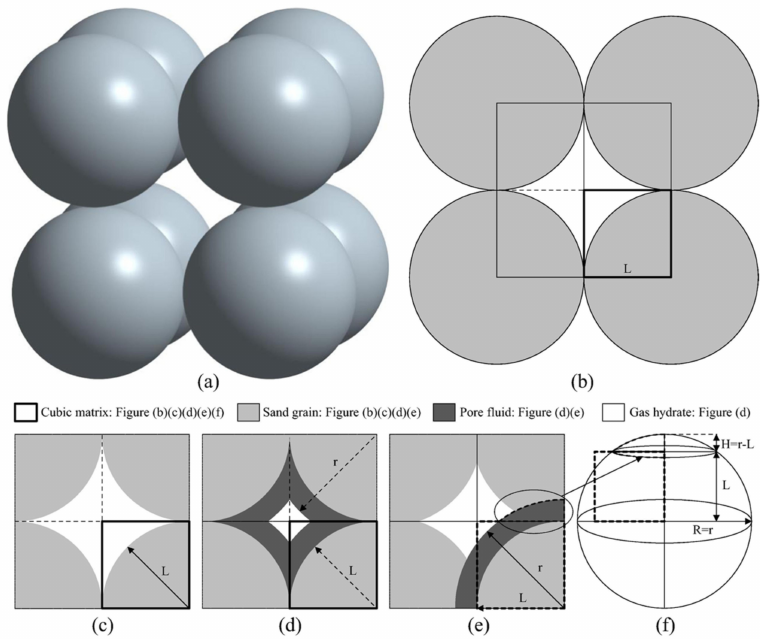
Figure 10. A model of a simple cubic sphere pack for unconsolidated quartz sands reprinted from [55] with permission from Elsevier. ( a ) Simple cubic sphere pack for unconsolidated quartz sands; ( b ) front view of simple cubic sphere pack model; ( c ) the sand grain and the pore space without hydrate; ( d ) the sand grain and the pore space filled with gas hydrate and the water shell around the grains; ( e , f ) the calculation process of the volume of the water shell within the